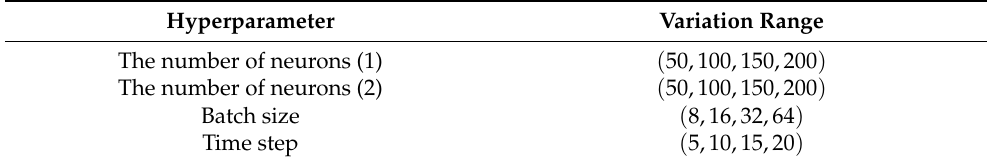
Table 2. The optimized hyperparameters and variation